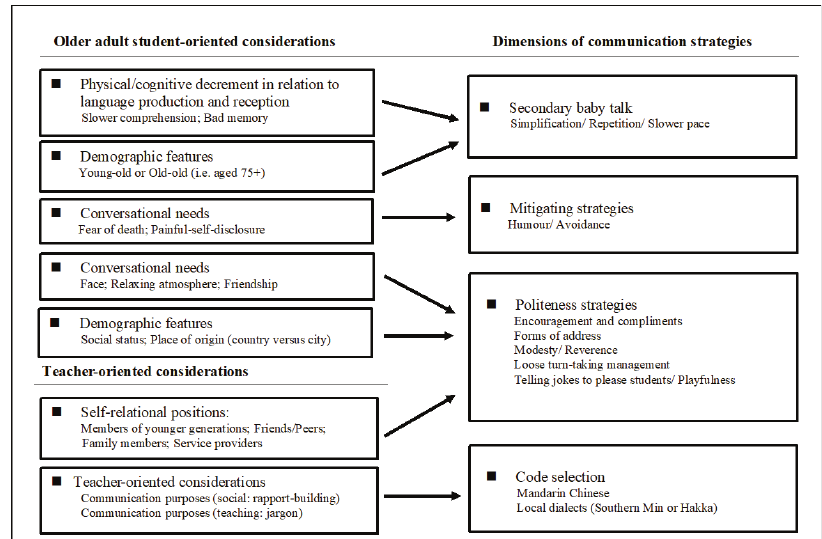
Figure 2. Teachers’ communication accommodation to older adult stu- dents in Taiwan: Considerations and